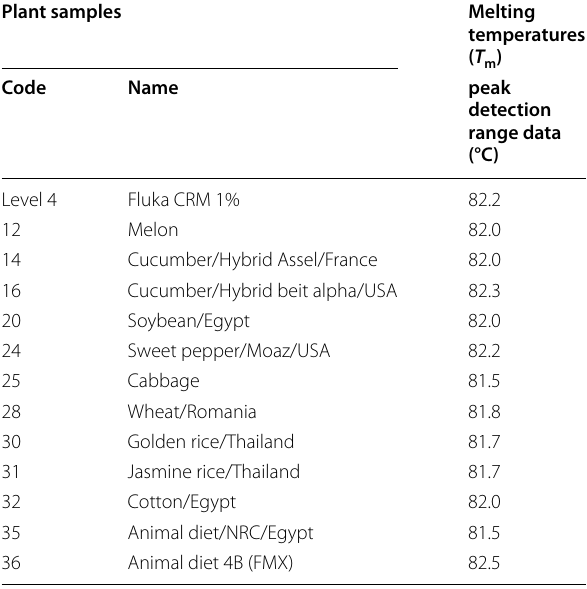
Table 3 Melt curve analysis: rate of changes of fluorescence due to amplicon dissociation of aphIV in tested samples and peak detection range data Plant